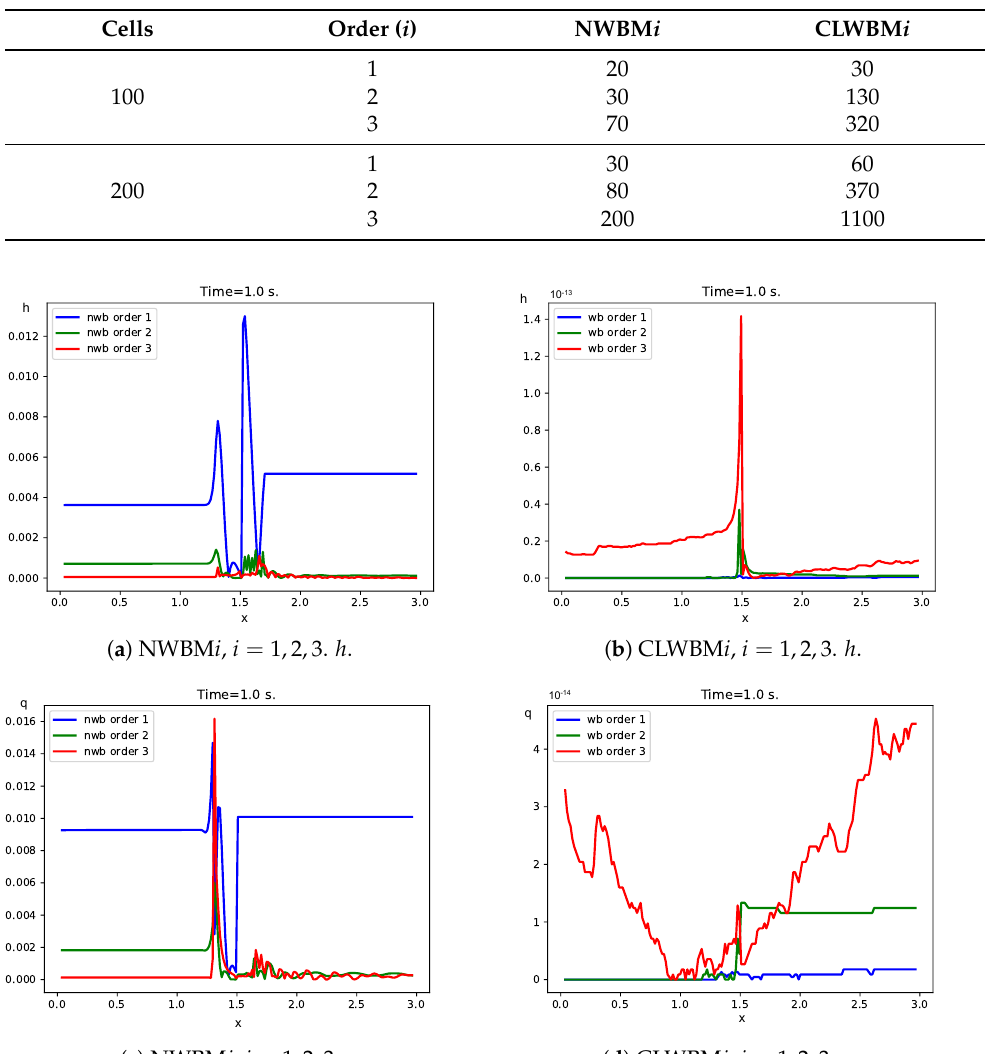
Table 11. Test 3.1. Computational cost (milliseconds). t = 1 s.